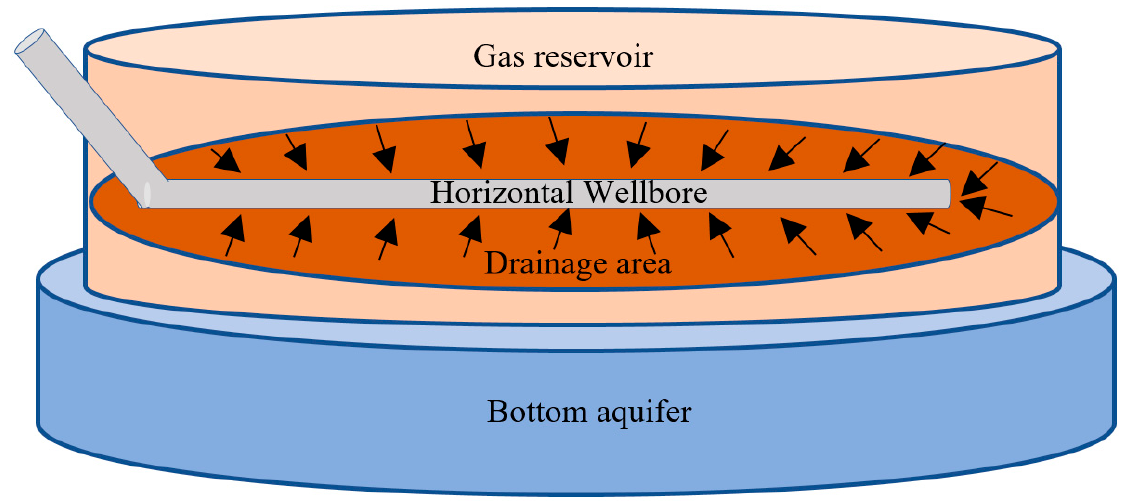
Figure 5. Basic schematics of a tight gas reservoir with bottom aquifer support.